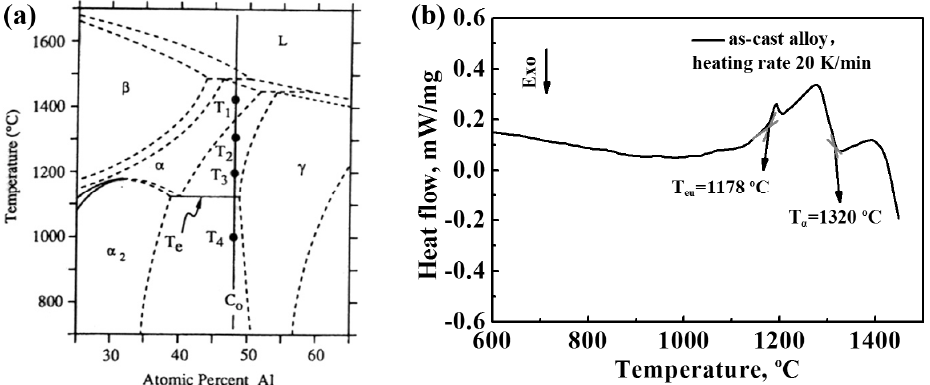
Figure 5. ( a ) Central portion of the binary Ti-Al phase diagram as described by Kothari et al. [22]; ( b ) heat flux DSC trace obtained from Ti-44Al-4Nb-1.5Cr-0.5Mo-0.2B alloy.